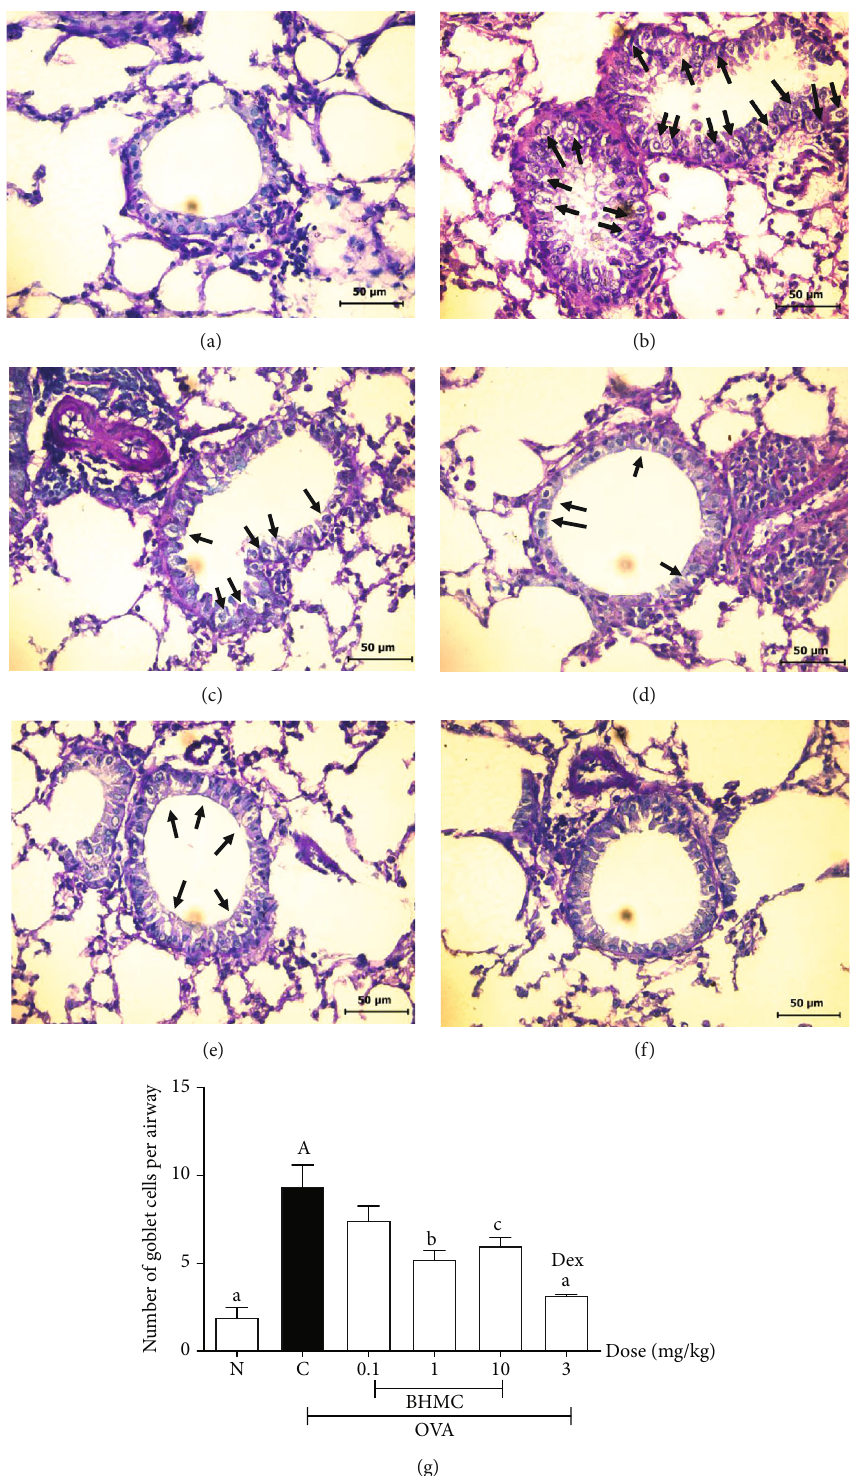
Figure 5: The e ff ect of BHMC on goblet cell hyperplasia in OVA-induced mice. After the BALF was collected, the lungs and trachea of the mice were processed into tissue sections ( n = 8 per group) and stained with periodic acid Schi ff (PAS) stain for histopathological evaluation of goblet cell hyperplasia. The representative images of lung sections from the (a) PBS group, (b) OVA group, (c) 0.1mg/kg BHMC group, (d) 1mg/kg BHMC group, (e) 10mg/kg BHMC group, and (f) DEX group. The goblet cells are indicated by black arrows. The representative images of lung sections were taken at 400x magni fi cation (40x for objective lens and 10x for ocular lens) using a light microscope. (g) The number of goblet cells in each airway was counted, and the sum of the goblet cells was divided by the total number of airways in each slide. The values are expressed as mean ± SEM . b: P < 0 : 01 and a: P < 0 : 005 , signi fi cantly di ff erent from the OVA group. A: P < 0 : 005 , signi fi cantly di ff erent from the N